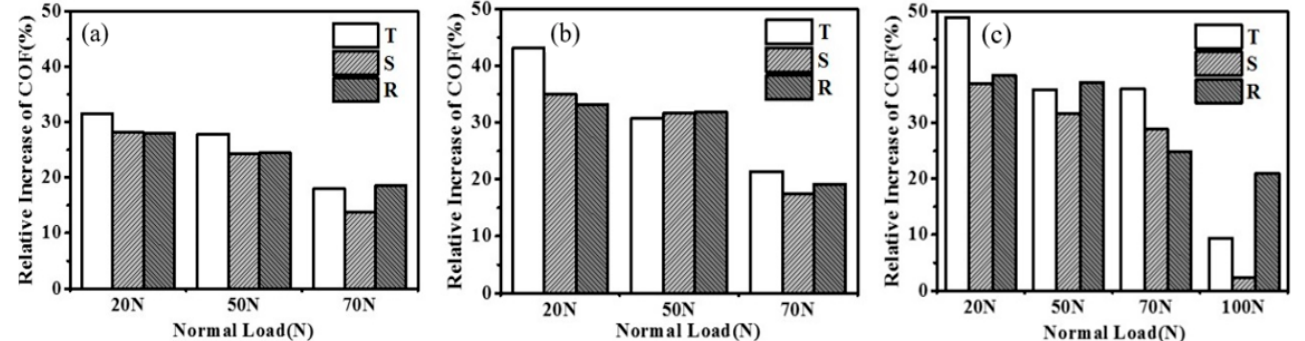
Figure 5. The influence of the other three textured specimens on the relative increases in COF compared with that of hexagon-textured specimens under different rotating speeds: ( a ) 50 rpm; ( b ) 100 rpm; ( a ) 250 rpm.